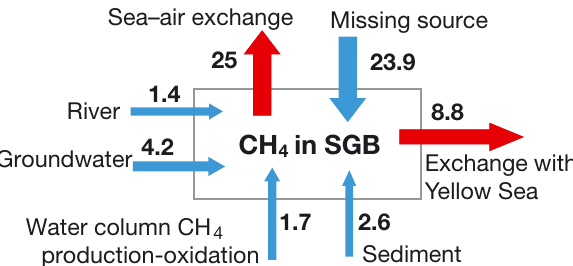
Fig. 11. Preliminary CH 4 budget (10 5 mol yr −1 ) estimation